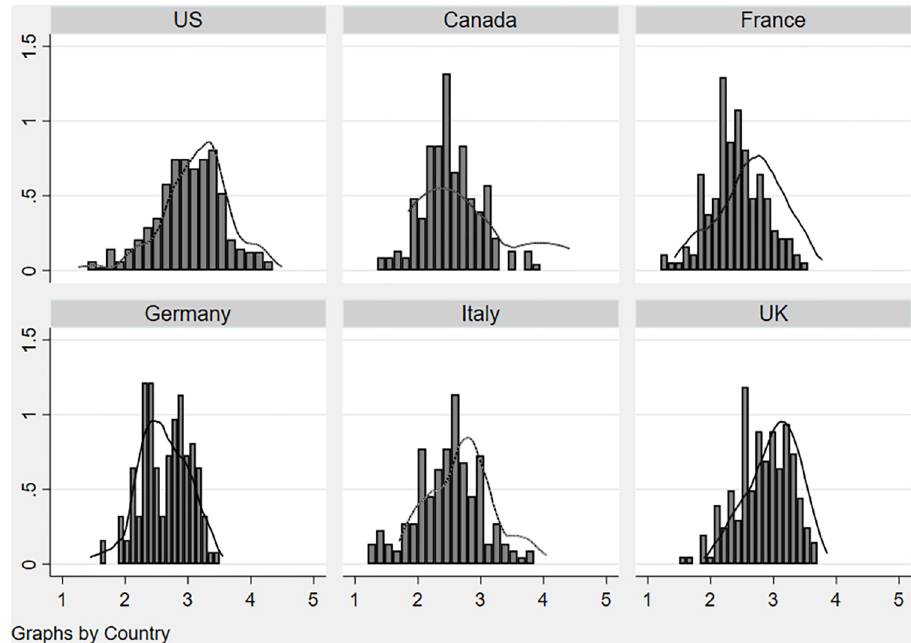
Fig 2. Distribution of management practices scores (public-private by country). Source: World Management Survey (Hospitals sub-sample).